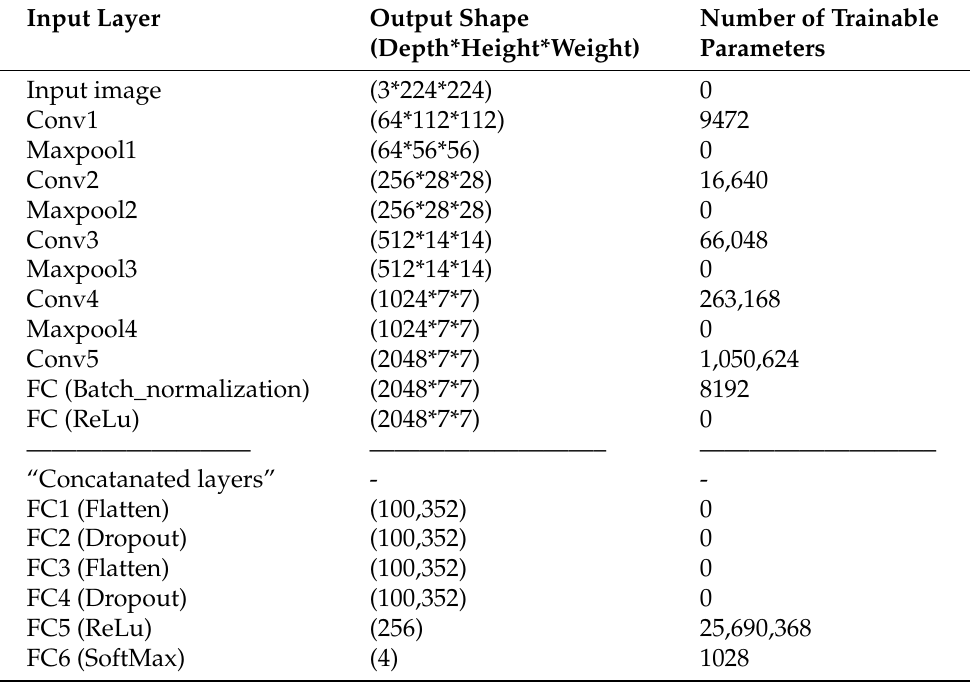
Table 3. Proposed model layer